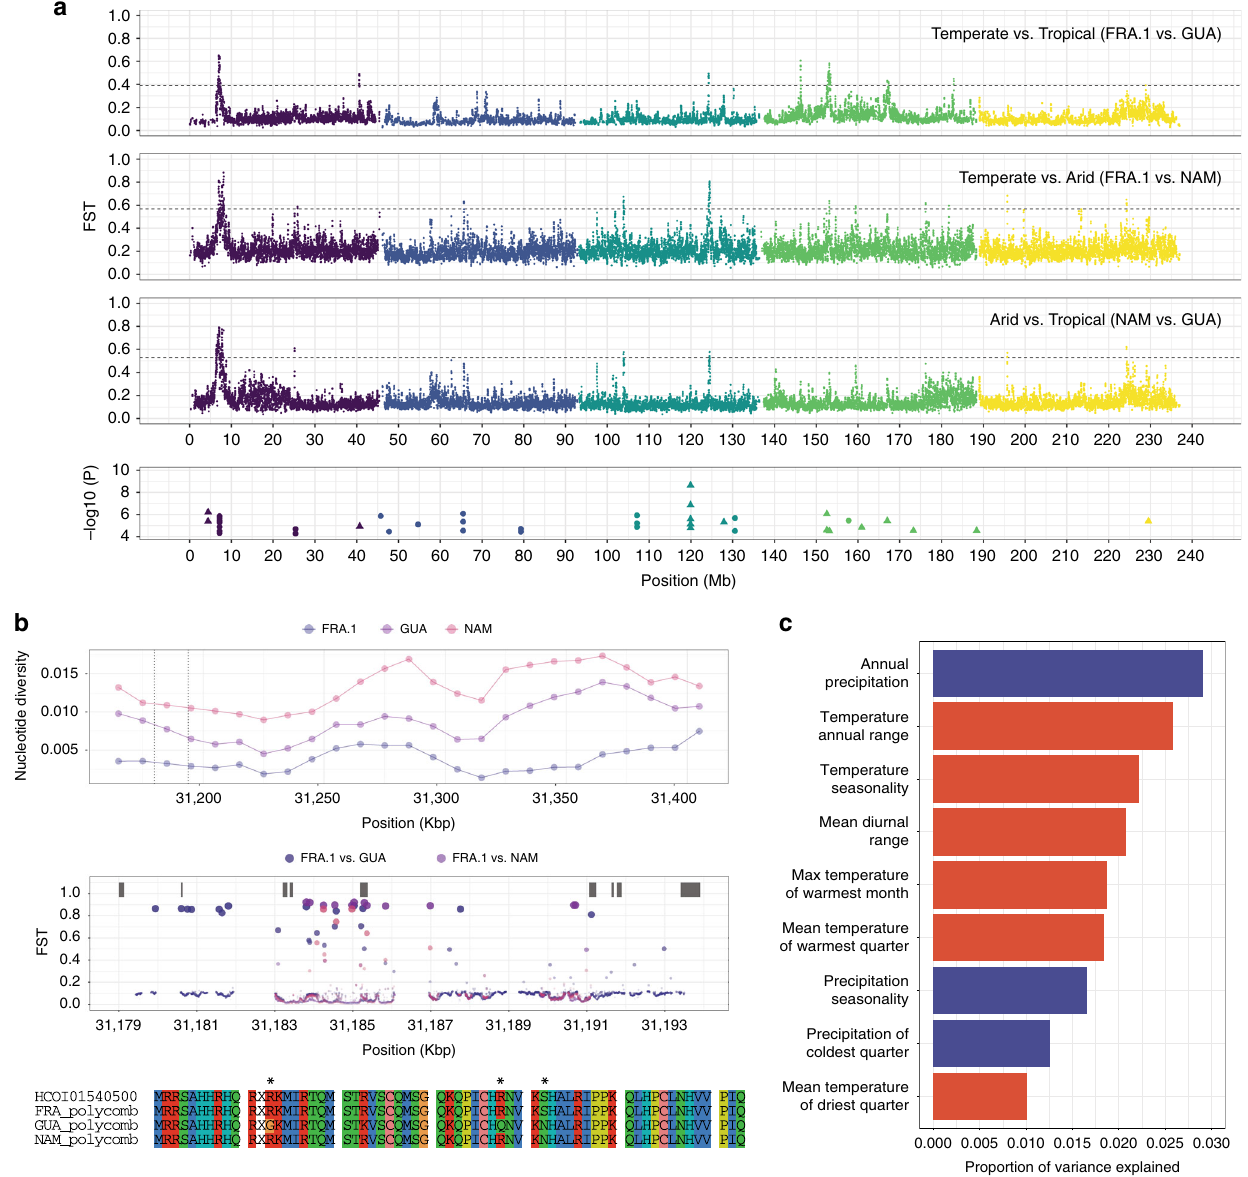
Fig. 6 Genomic signal of climate adaptation. a Top three panels represent F ST values plotted against genomic position (Mbp), coloured and ordered by chromosome name (from I in purple to V in yellow). Horizontal dashed line represents the 0.5% quantile. Bottom panel shows genomic positions of signi fi cant associations between annual precipitation (circle) and temperature annual range (triangle). In that case, − log10(P) refers to log-transformed P values estimated by the Latent Factor Mixed Model analysis. b A Polycomb group protein coding gene ( Pc ) underpins major differentiation signal across climatic conditions. Top panel shows nucleotide diversity estimates for 10-Kbp genomic windows spanning windows of chromosome III with high genetic differentiation between populations from arid, temperate and tropical areas. Dashed lines indicate the Pc ortholog boundaries. Within these boundaries, F ST estimates along every base-pair of the gene sequence are represented below (circle size proportional to F ST coef fi cient), with predicted exon model shown as grey rectangles. The bottom panel shows translated consensus sequences of exon 5 for populations of interest with asterisks marking mutations. c Proportion of genetic variance explained by climatic variables. Variants from eight isolates with no record of ivermectin resistance (AUS.2, FRA.1, GUA, IND, MOR, NAM, STO, ZAI) were analysed against a set of nine variables (from a total of 19, either precipitation- or temperature-associated coloured in blue and red respectively), selected to minimise correlation between variables. Annual precipitation (BIO12) and temperature annual range (BIO7) are main contributors of genetic